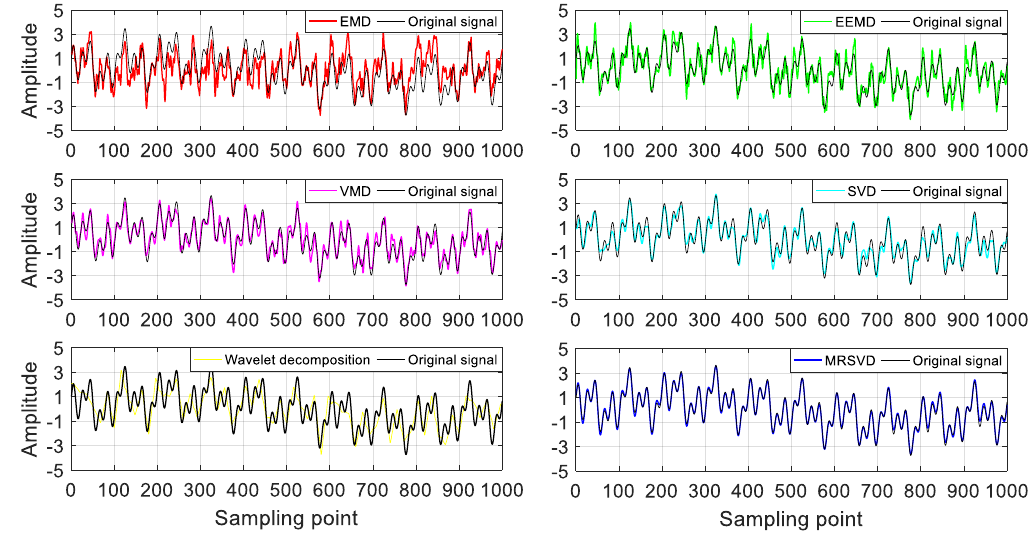
Figure 7. Noise reduction wave in multiple models on signal x 2. Table 4. SNR of various noise reduction models at different noise powers.